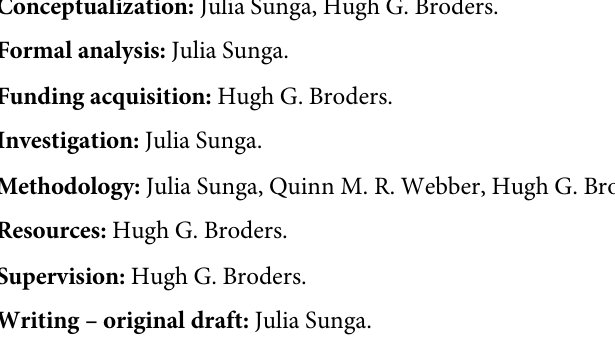
S1 Fig. Influence of number of individuals and number of observations per individual on estimates of clustering coefficient (all observation levels). Horizonal red line represents the value of the ‘observed’ network at 0.828. S2 Fig. Influence of number of individuals and number of observations per individual on estimates of graph density (all observation levels). Horizontal red line represents the value of the ‘observed’ network at 0.675. S3 Fig. Influence of number of individuals and number of observations per individual on estimates of community assortativity (R ; all observation levels). Horizontal blue line com represents the threshold value of 0.5 and the horizontal red line indicates the value of the ‘observed’ network at 0.858. S4 Fig. Influence of number of individuals and number of observations per individual on the proportion of similarity in dyad assignment (all observation